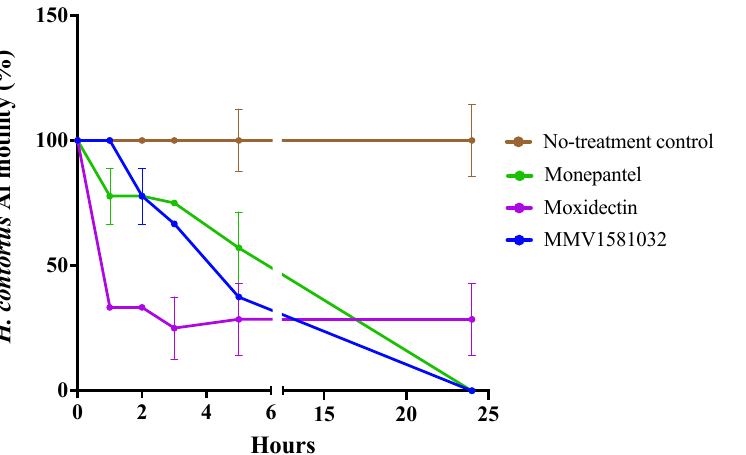
Figure 3. In vitro motility inhibition (%) of MMV1581032 on adult females of Haemonchus contortus with reference to two control compounds (monepantel and moxidectin) over a period of 24 h. Motility scores (assessed at 1-, 2-, 3-, 5- and 24-h time points; cf. [29]) for each compound were calculated, normalised with reference to the negative control (100% motility) and were recorded as a percentage. Data points represent one experiment conducted in triplicate; mean ± standard deviation (SD).